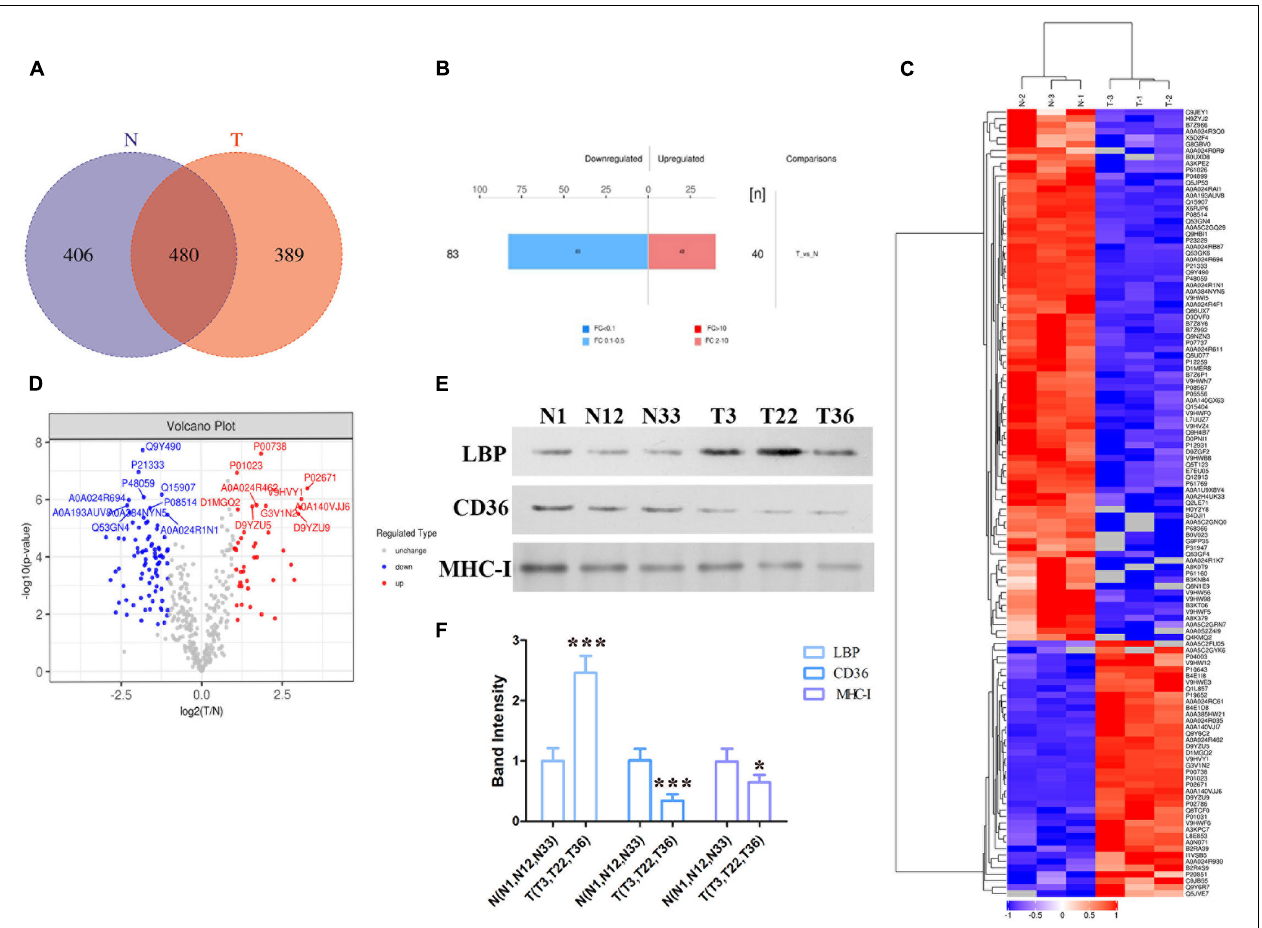
FIGURE 2 | Bioinformatics analysis of exosome differential proteins. (A) Venn diagram illustrating overlapping proteins in the two independent MS experiments (T vs. N). (B) Histogram of quantitative difference results of two groups of MS experimental proteins, including 40 up-regulated proteins and 83 down-regulated proteins. (C) Heat map of the protein levels of shared proteins among exosomes released from the serum of normal individuals and patients with ATB. (D) Volcano diagram of differential expression of exosome proteins between the two groups (T vs. N). (E,F) Differential proteins (LBP, CD36, and MHC-I) in exosomes of the two groups (T vs. N) were quantified via western blotting. * p < 0.05, *** p < 0.001.